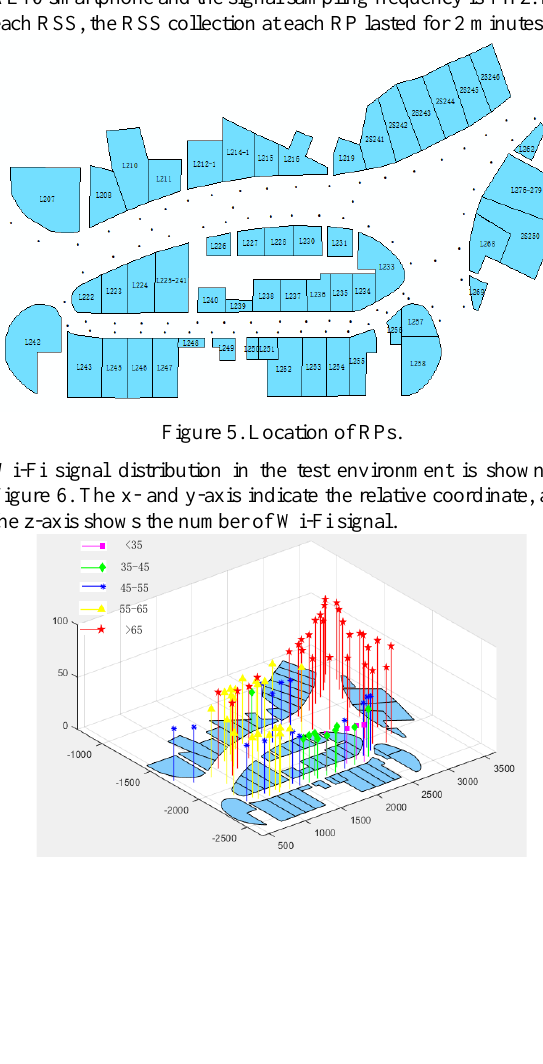
Figure 7. Near boundary of ROs.